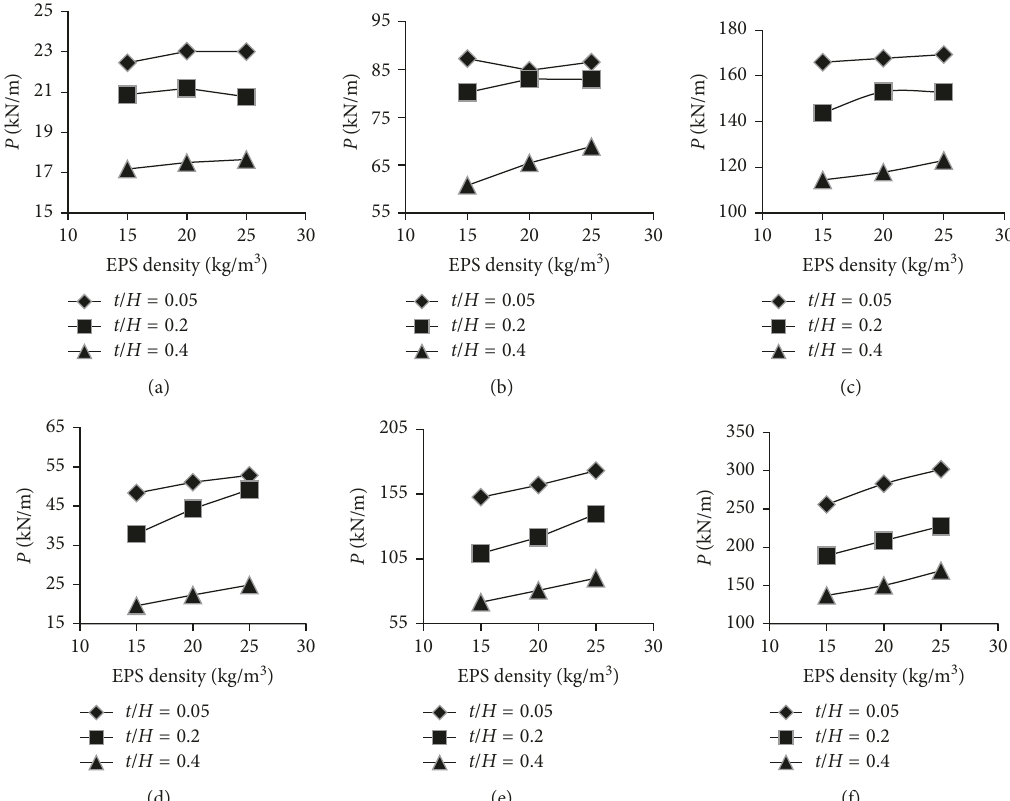
Figure 5: Influence of geofoam density on static forces on the cantilever retaining walls: (a, b, and c) yielding retaining walls and (d, e, and f) nonyielding retaining walls. (a) H � 3 m. (b) H � 6m. (c) H � 9m. (d) H � 3 m. (e) H � 6 m. (f) H � 9